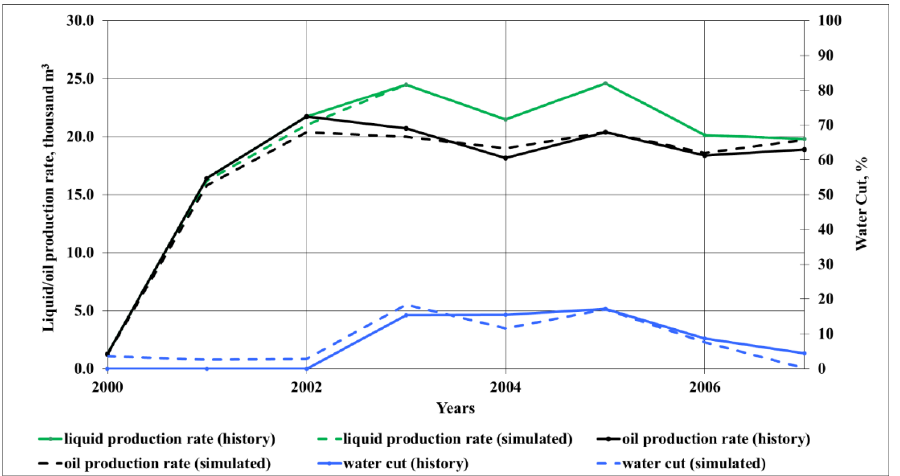
Figure 6. Results of history-matching .